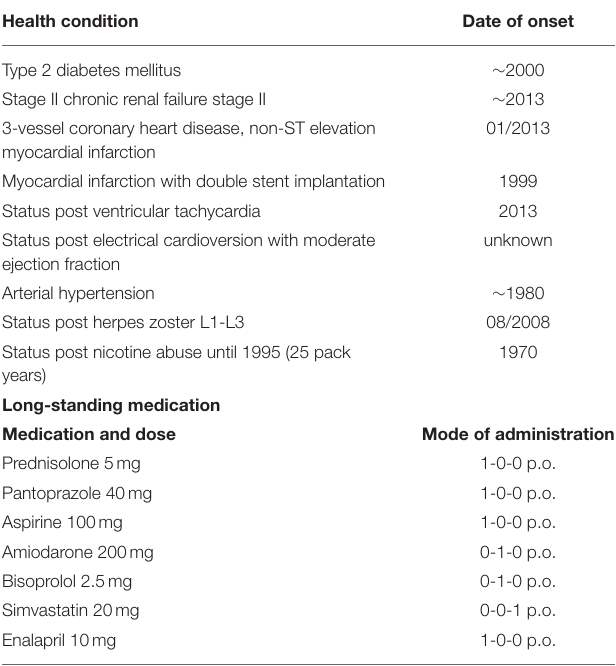
TABLE 1 | Additional patient’s health